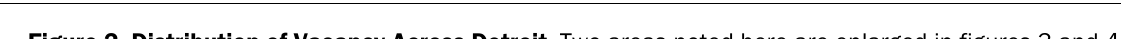
Figure 2. Distribution of Vacancy Across Detroit. Two areas noted here are enlarged in figures 3 and